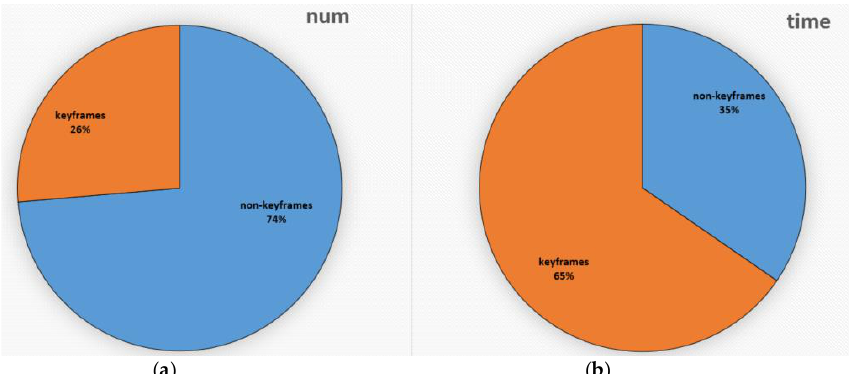
Figure 9. The left picture ( a ) shows a comparison of the number of keyframes and non-keyframes. The right picture ( b ) shows the comparison of time consumption between tracking keyframes and non-keyframes